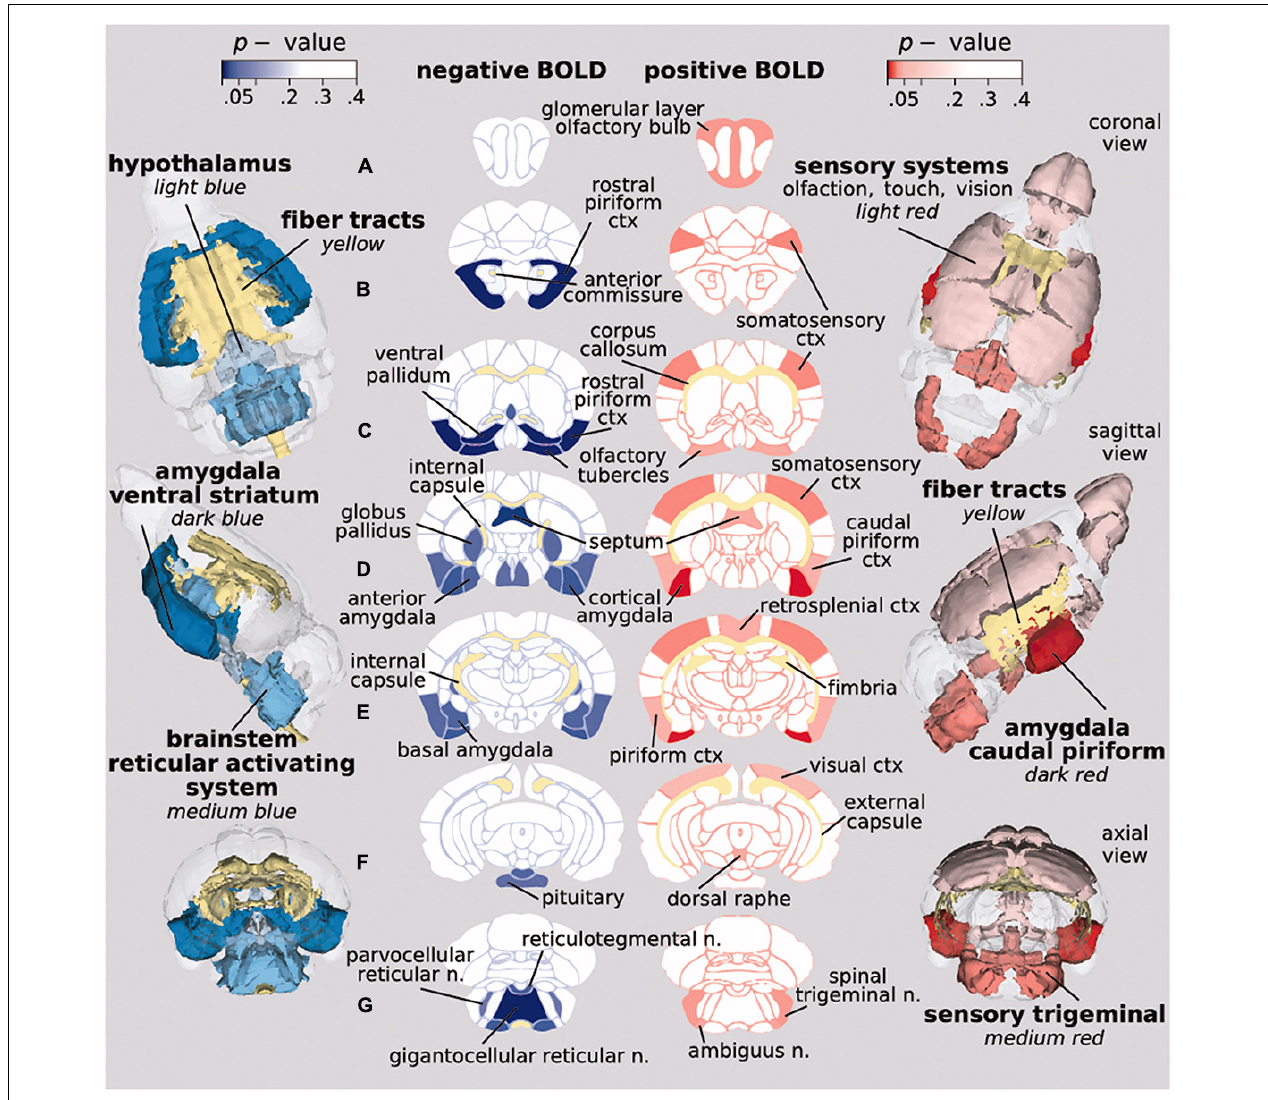
FIGURE 4 | Activation maps on inhaled vaporized cannabis. Probability maps showing significant changes in BOLD signal in brain areas that differed in mice exposed to inhaled cannabis or placebo. Positive BOLD (red) reflects an increase in signal, while negative BOLD (blue) indicates a decrease. (Adapted with permission from Farra et al.